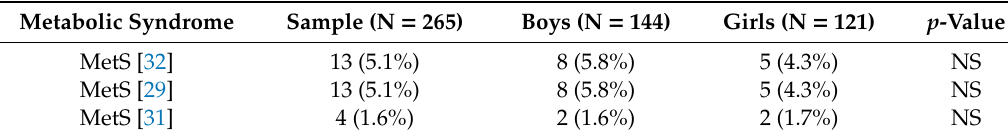
Table 2. Prevalence of the metabolic